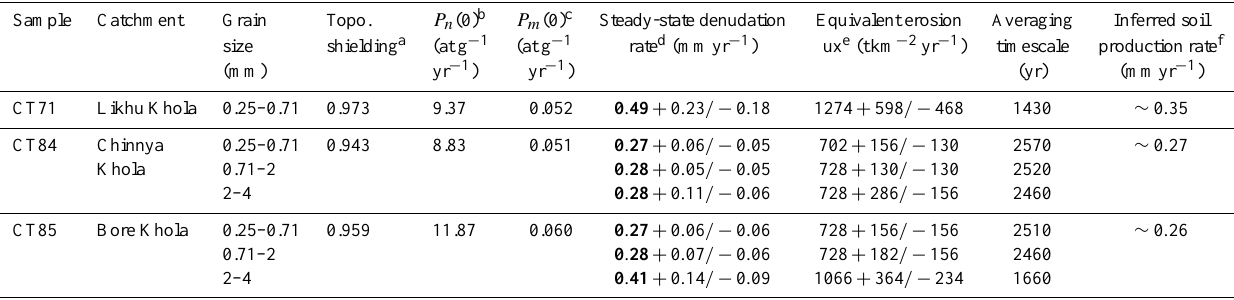
Table 3. Cosmogenic production rates and inferred denudation rates for Likhu Khola samples.